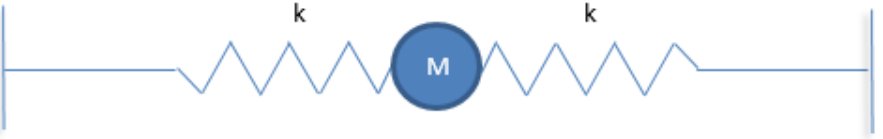
Figure 13. Simplified system used to estimate natural periods.